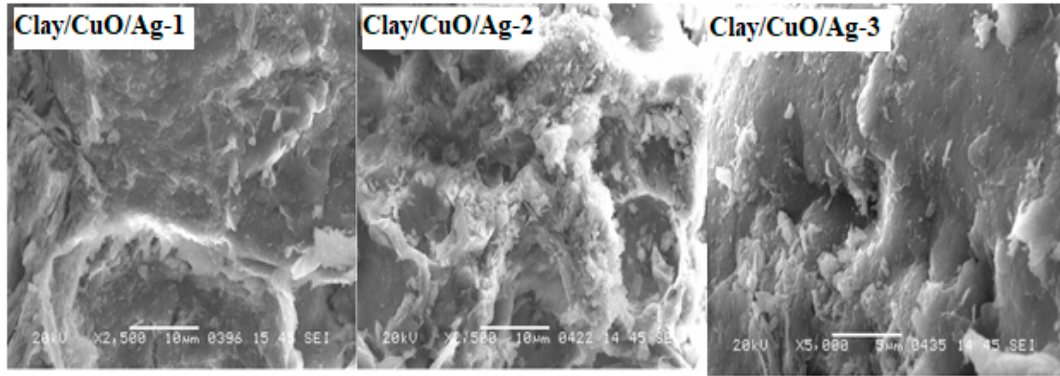
Figure 11. Scanning electron microscope (SEM) micrograph of clay/CuO/Ag-1, clay/CuO/Ag-2 and clay/CuO/Ag-3.